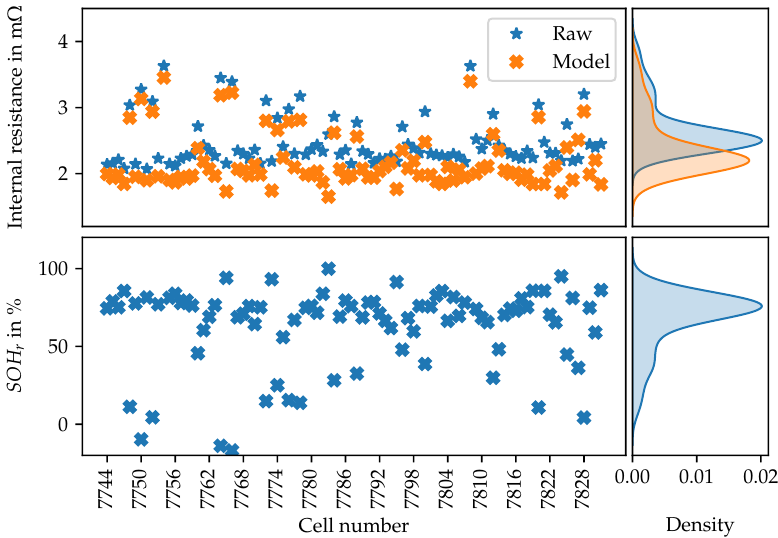
Figure 11. ( Top ): Internal resistance of all cells. The raw values are the average values of all samples passed through the ECM. The model data are the results of the ECM fitted over SOC and temperature, and evaluated at 18°C and a SOC of 60%. ( Bottom ): SOH r of the cells. The SOH r cannot be compared to the SOH c . Reference for SOH r : SOH r = 0 at 60% increase of R bol . On the right side, we show the kernel density estimation ( KDE ) of the internal resistance and the resulting SOH r